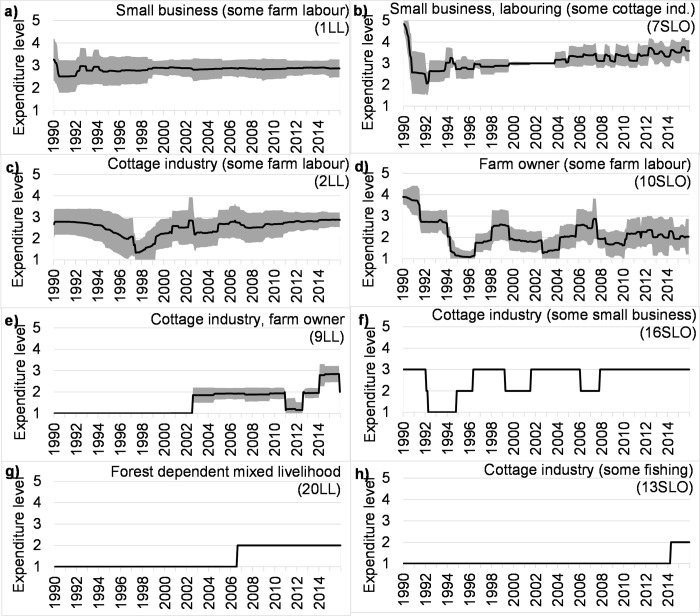
Simulated mean and ±1std range of expenditure level (1: poorest, 5: least poor) of selected household livelihood archetypes of coastal Bangladesh.Archetype ID is in brackets.